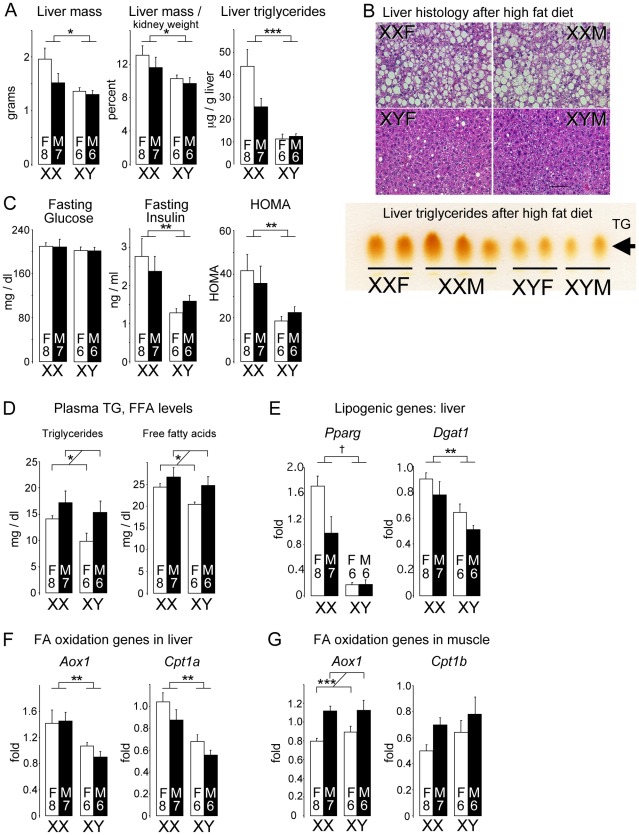
Diet-induced fatty liver and impaired glucose homeostasis are more pronounced in XX than XY mice.FCG mice were fed a high fat-high carbohydrate diet for 16 weeks. All values represent mean ± SEM. (A) XX mice had increased liver mass and hepatic triglyceride levels compared to XY mice. (B) Hematoxylin and eosin staining of liver sections shows hepatic lipid droplet accumulation in XX mice. In the lower panel, thin layer chromatography demonstrates increased triglyceride levels in liver of XX mice relative to XY mice. (C) Fasting glucose and insulin levels, and homeostatic model assessment (HOMA) were determined. XX mice had significantly higher insulin levels than XY mice. (D) Fasting plasma triglyceride (TG) and free fatty acid (FFA) levels were higher in gonadal males than in gonadal females. (E) Increased triglyceride accumulation in XX liver is associated with increased peroxisome proliferator-activated receptor γ (Pparg) and diacylglycerol acyltransferase 1 (Dgat1) mRNA levels. (F) Increased expression levels for fatty acid oxidation genes acyl CoA oxidase 1 (Aox1) and carnitine palmitoyltransferase 1α (Cpt1a) in liver of XX mice. (G) Increased expression of Aox1 in skeletal muscle of gonadal male mice. *, p<0.05; **, p<0.01; ***, p<0.001; †, p<0.0001.